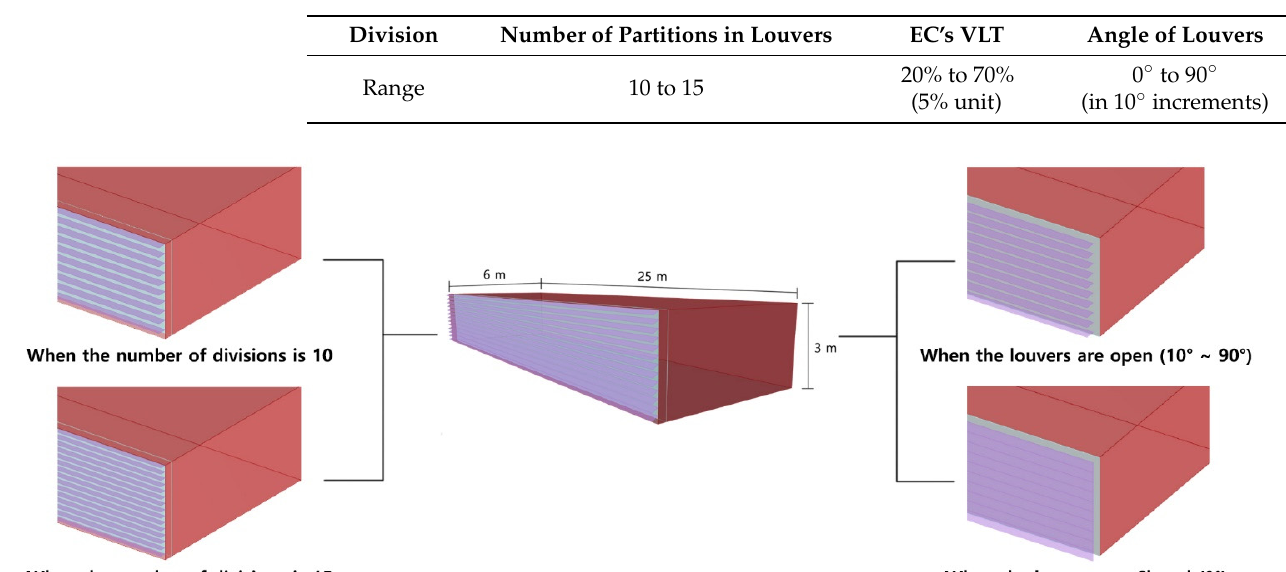
Table 3. Manipulative variables.